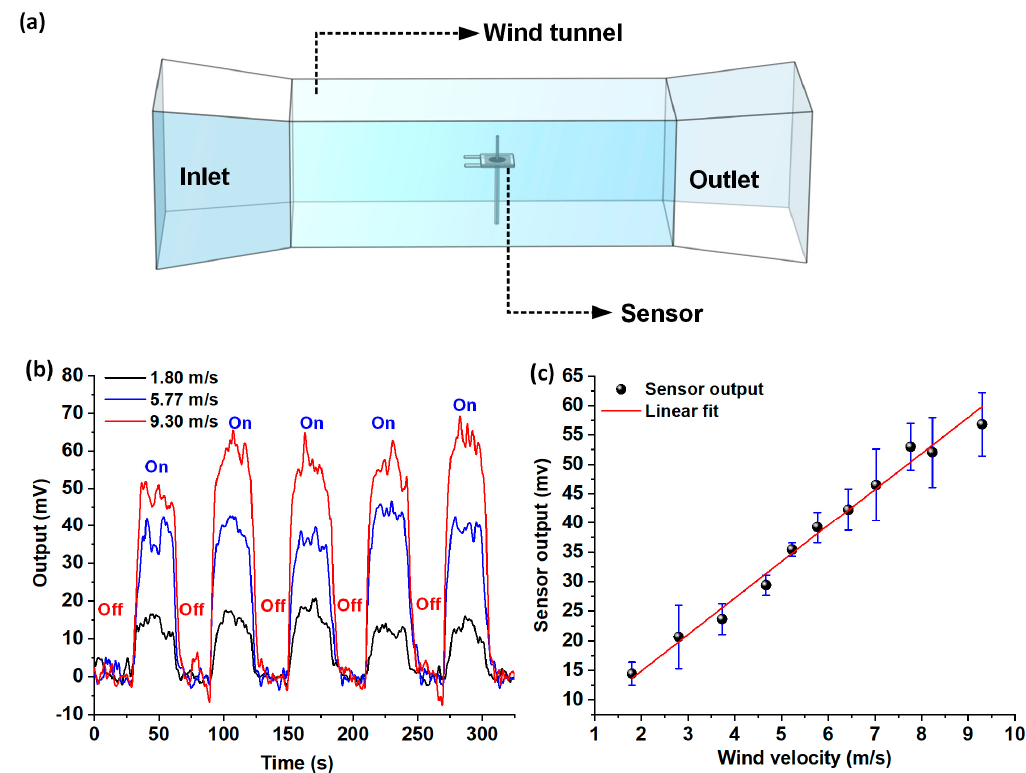
Figure 6. Steady-state airflow sensing characterization: ( a ) Schematic representation of the experimental setup involving the wind tunnel for steady-state flow calibration; ( b ) Superimposition plot showing the voltage response of the sensor for three different airflow velocities; ( c ) Plot showing the Wheatstone bridge output versus the airflow velocity, in the range 1.8–9.3 m/s.